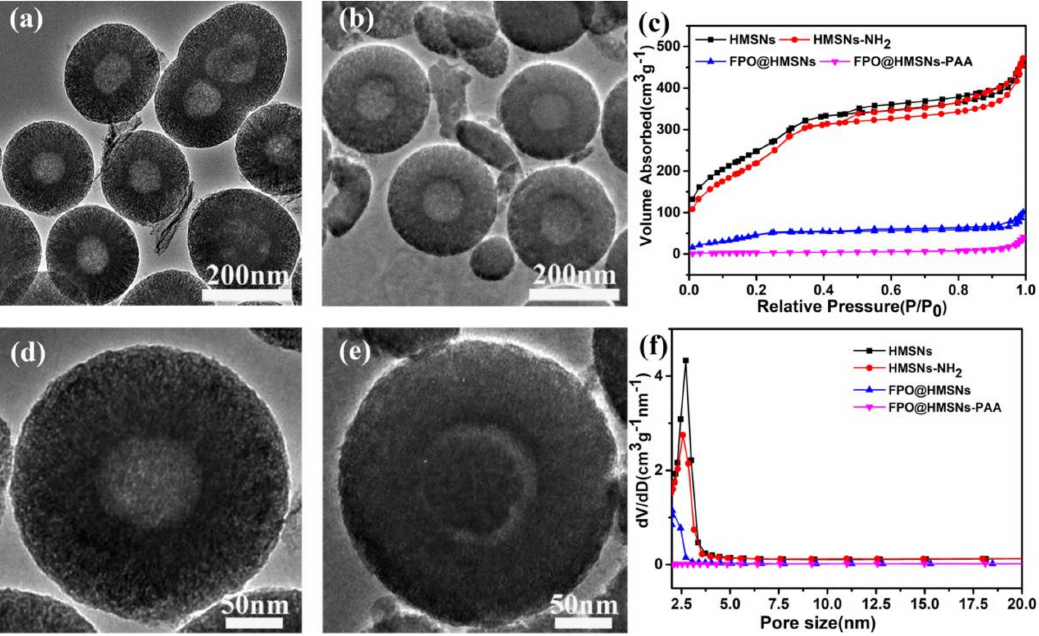
Figure 1. TEM images of hollow mesoporous silica nanoparticles (HMSNs) ( a , d ); HMSNs-polyacrylic acid (PAA) ( b ) and FPO@HMSNs-PAA ( e ). Adsorption-desorption isotherms of HMSNs, HMSNs-NH 2 ,